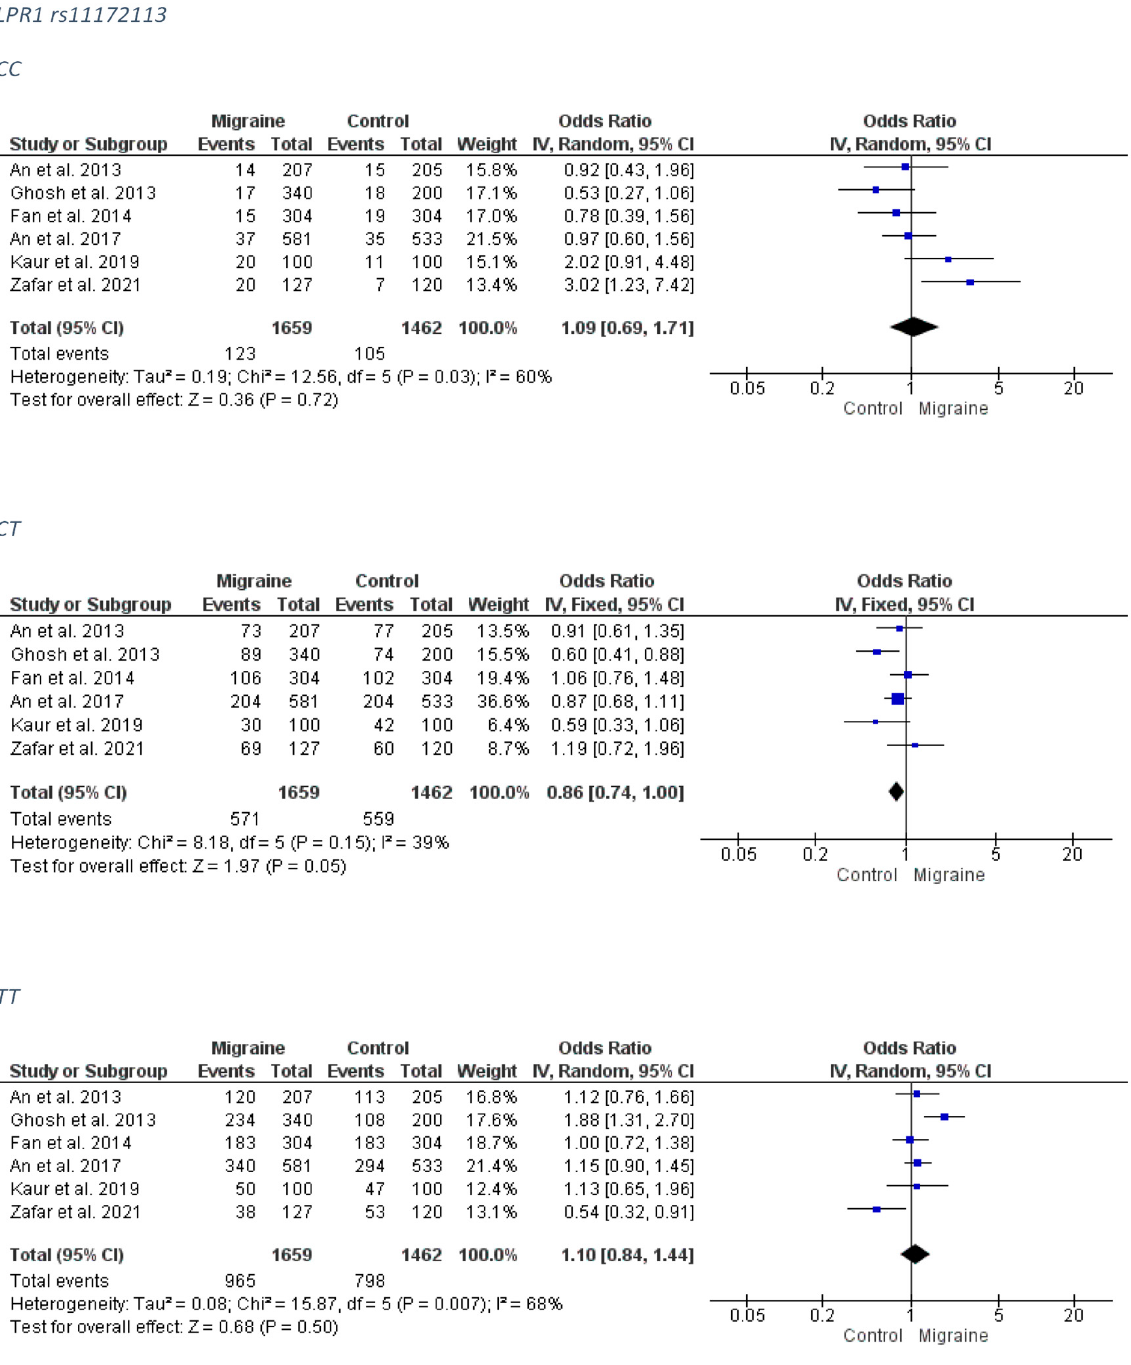
Figure 7. The forest plots presenting the results from meta-analysis of the rs11172113 and overall migraine group .